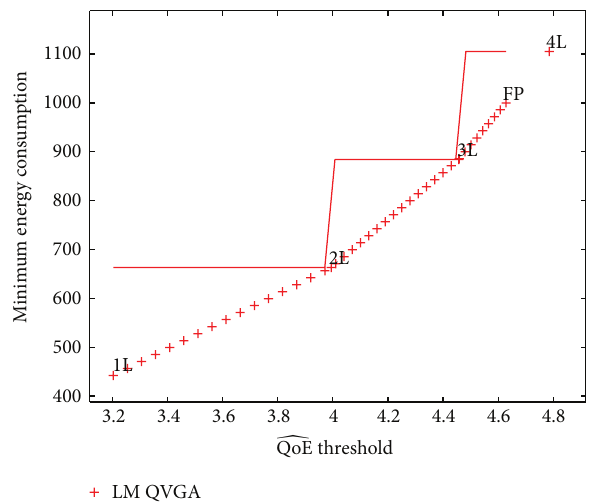
Figure 1: Comparison between basic strategy and energy optimiza- tion.